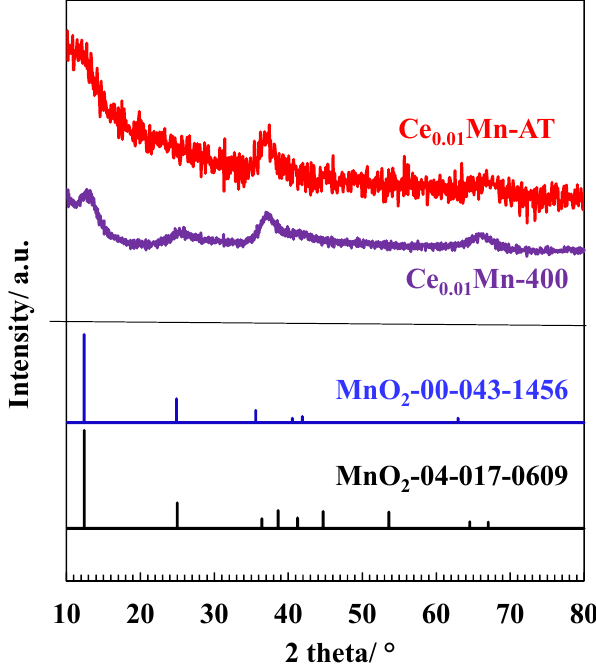
Figure 1. XRD patterns of the Ce 0.01 Mn-400 and Ce 0.01 Mn-AT samples. Table 1. Weight composition and atomic ratio for the Ce 0.01 Mn-400 and Ce 0.01 Mn-AT